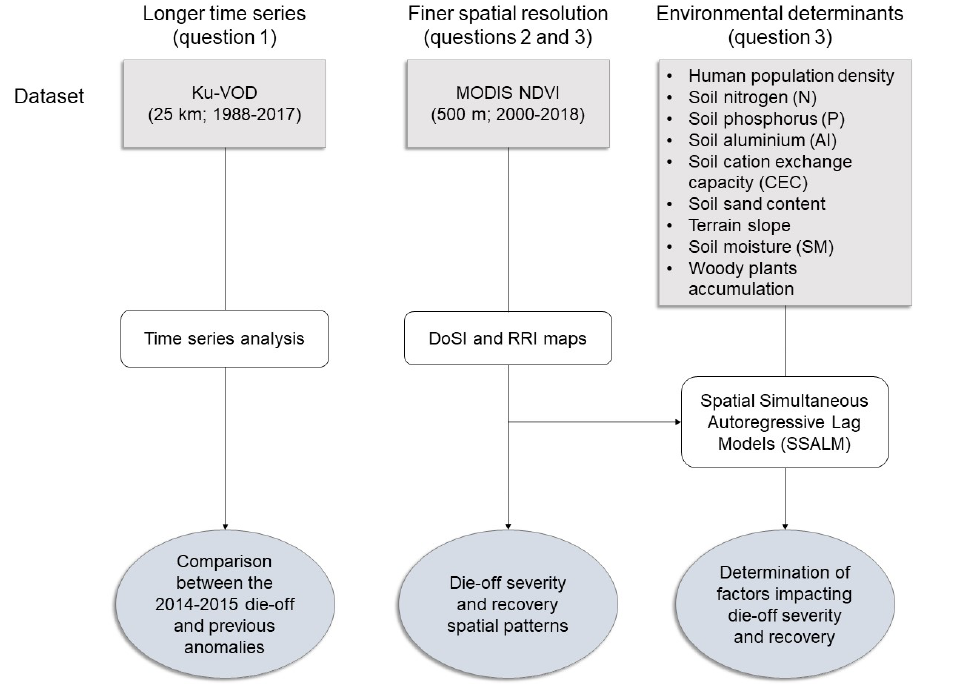
Figure 3. Flowchart summarizing datasets used and the outputs of each analysis. The research question(s) which relates to each dataset and/or analysis is also